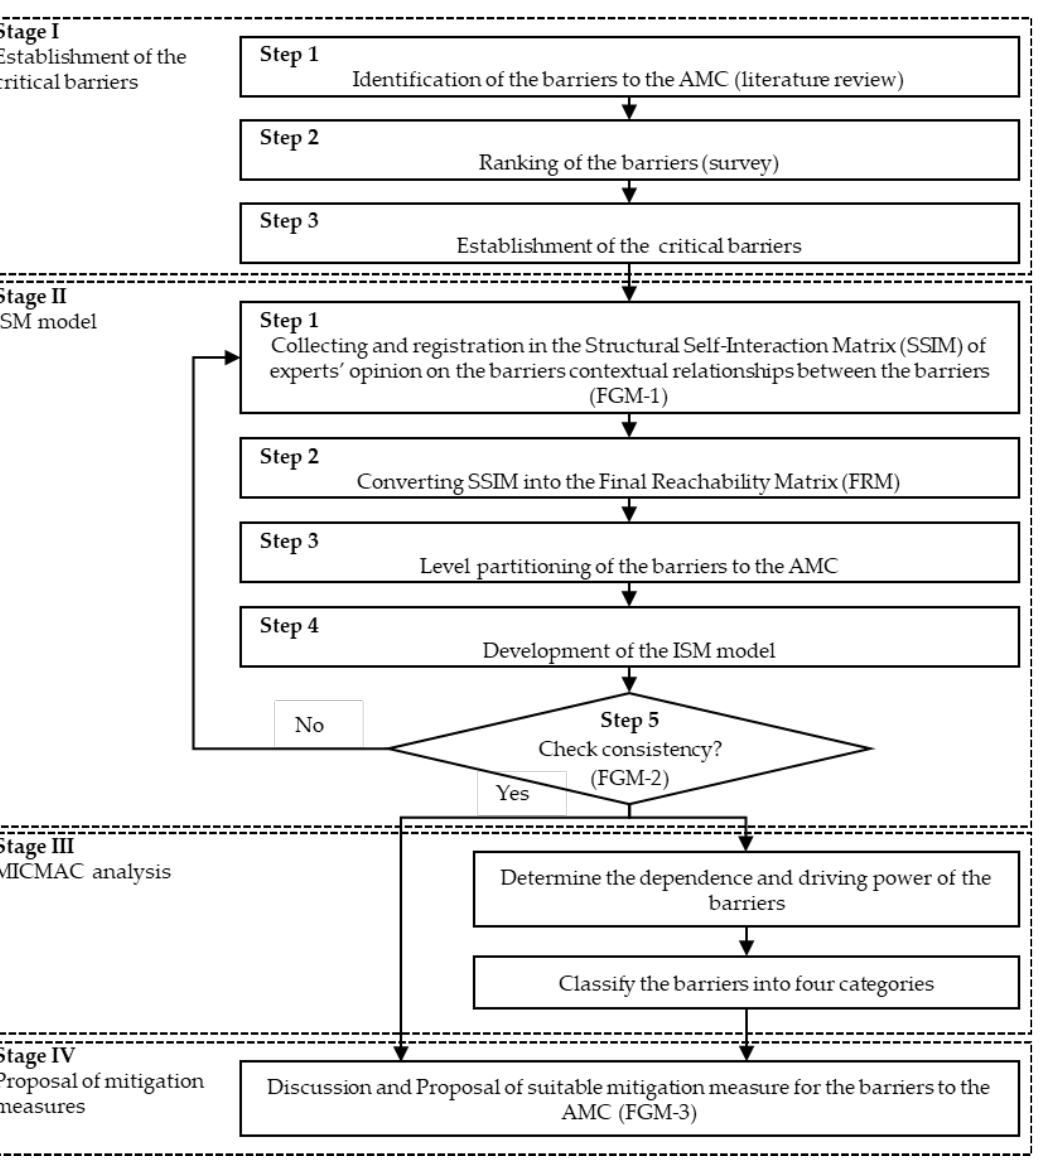
Figure 1. Research methodology.